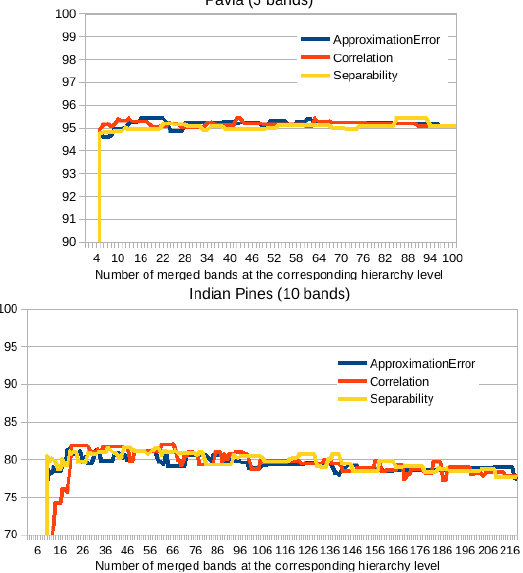
Figure 6: Kappa (in %) reached for rbf SVM classification for merged band subsets selected at the different levels of the hier- archy for Pavia and Indian Pines data sets using the greedy FS algorithm (x-axis = number of merged bands in the spectral con- figuration corresponding to the hierarchy